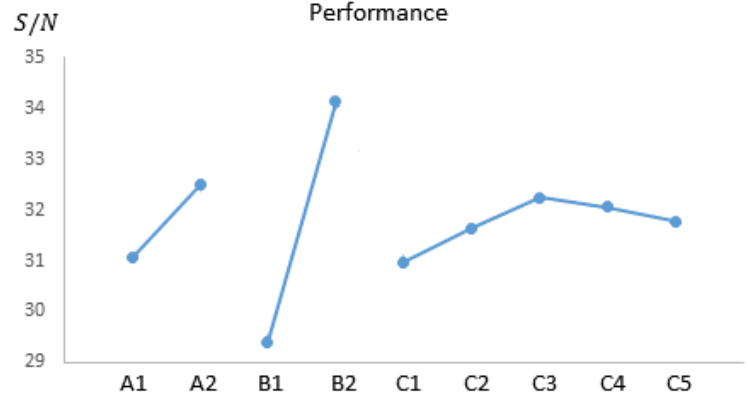
Figure 2. The graph of marginal S / N ratio for all levels of the factors when the ∆𝑇 criterion is considered.